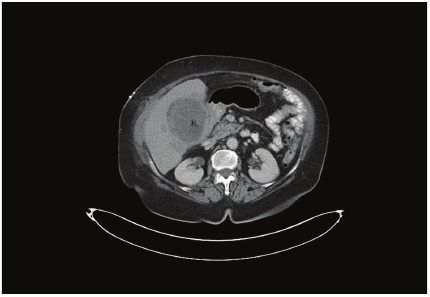
Figure 1: Computed tomography scan showing a 8 × 5 cm mass at the gallbladder bed (arrow) with two satellite lesions in the right hepatic lobe.